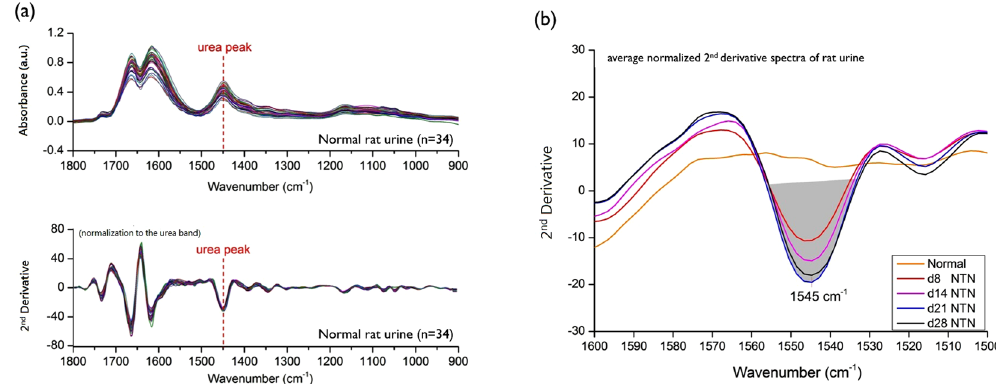
Figure 1. Fourier transform infrared (FTIR) analysis of rat urine: urine spectral normalization, second derivative conversion and integration. ( a ) Absorbance spectra of each dried urine sample were recorded from 34 normal rats (upper graph). Later, the urine spectra were individually normalized to the urea band at 1450 cm − 1 (1477~1427 cm − 1 ) followed by transformation to 2 nd derivative forms (lower graph). ( b ) The urine 1545 cm − 1 peak was integrated by measuring the peak area between 1558 and 1532 cm − 1